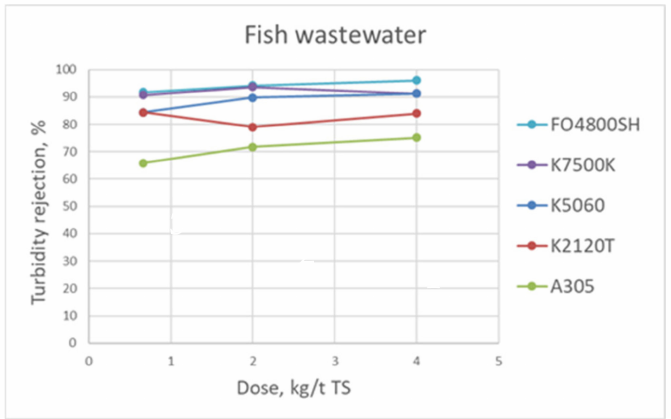
Figure 5. Turbidity rejection as a function of polymer active dose for the fish wastewater at laboratory scale